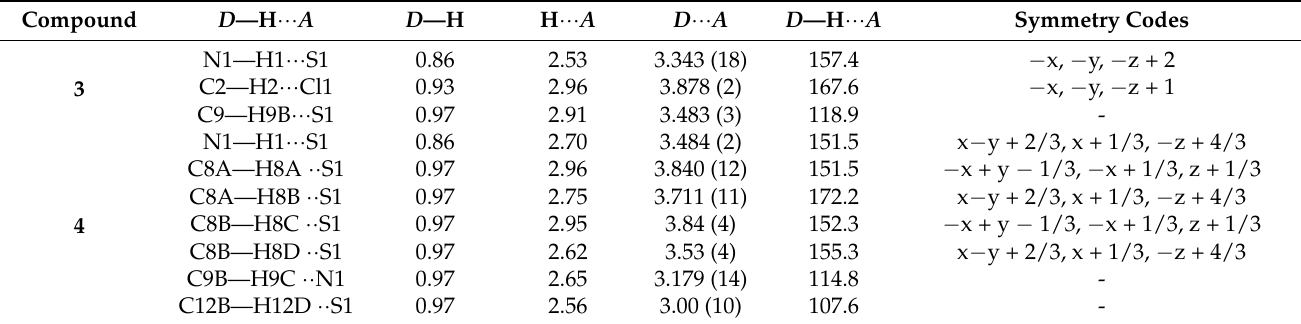
Table 3. Hydrogen-bond geometries (Å) of compounds 3 and 4